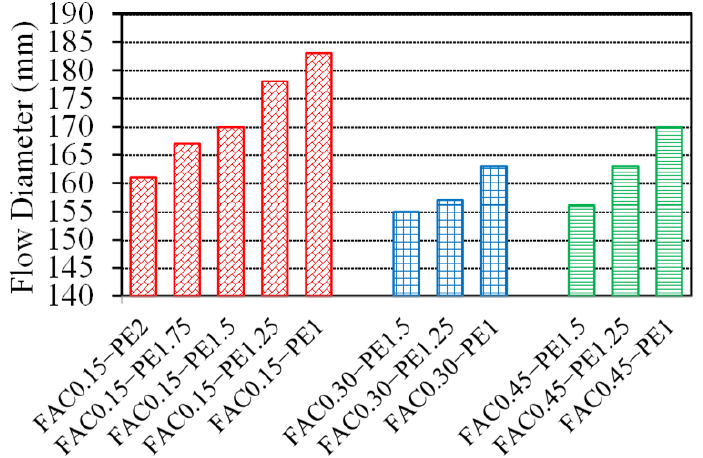
Figure 11. Flow diameters of GLECC